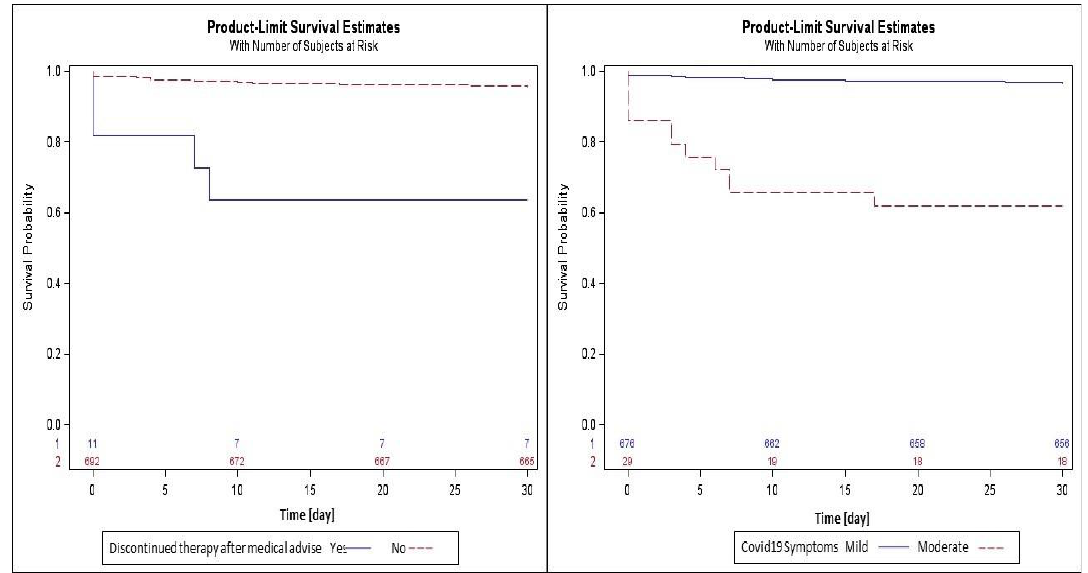
Figure 1. Survival curves drawn with the Kaplan – Meier method for the parameter COVID-19 symptoms and discontinuation of therapy for medical advice.